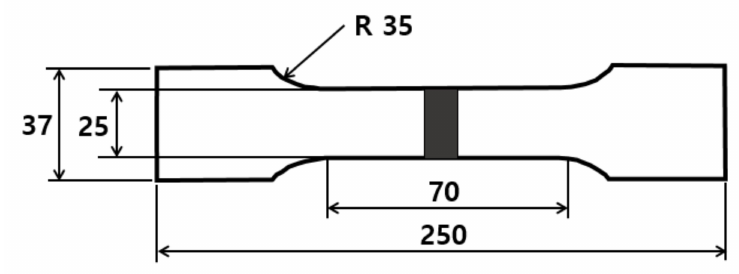
Figure 4. Configuration of tensile specimen, thickness 10